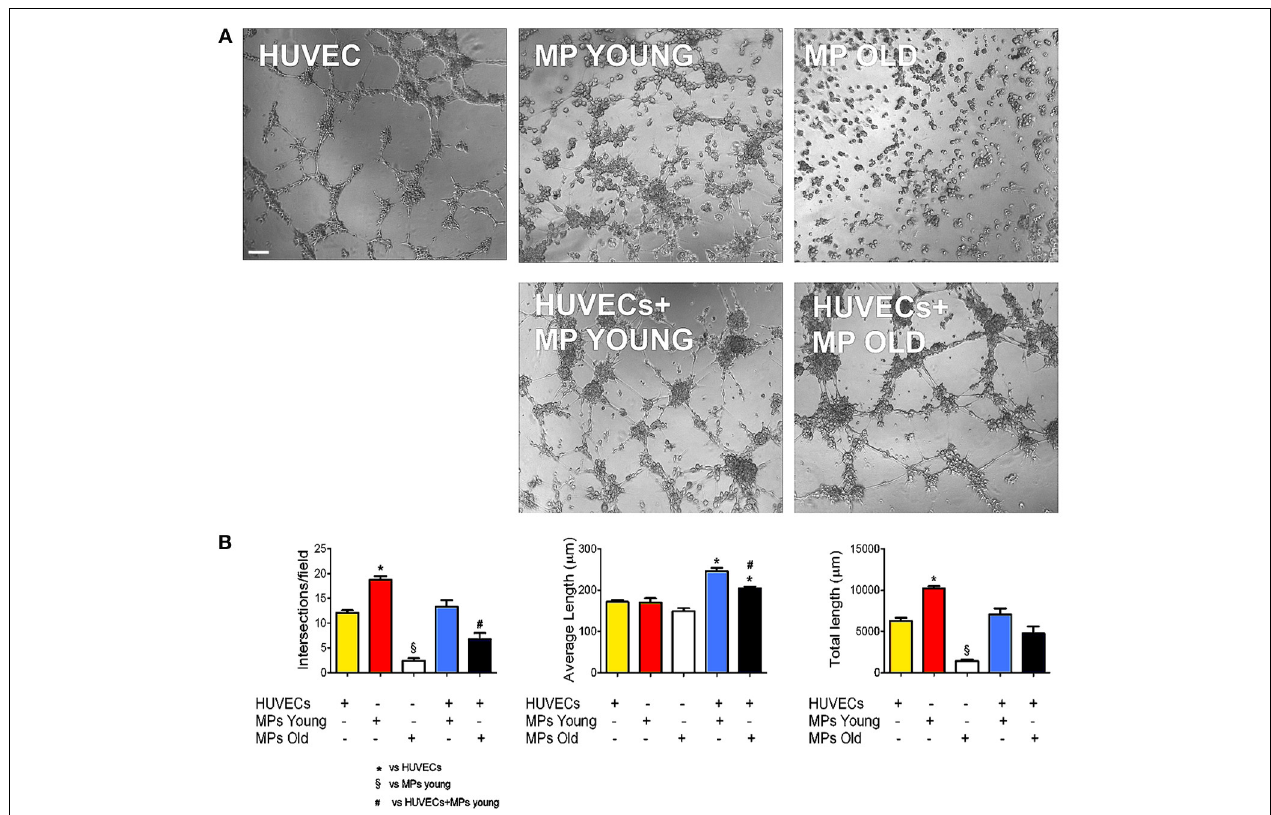
FIGURE 2 | Ability of MP to form capillary-like structures in vitro . Endothelial cell networking in vitro on Matrigel. (A) Phase-contrast microphotographs showing human umbilical vascular endothelial cell (HUVEC) and muscle-derived pericyte (MP) capacity to form networks on Matrigel, alone and in co-culture (1:4 MP:HUVEC ratio). (B) The